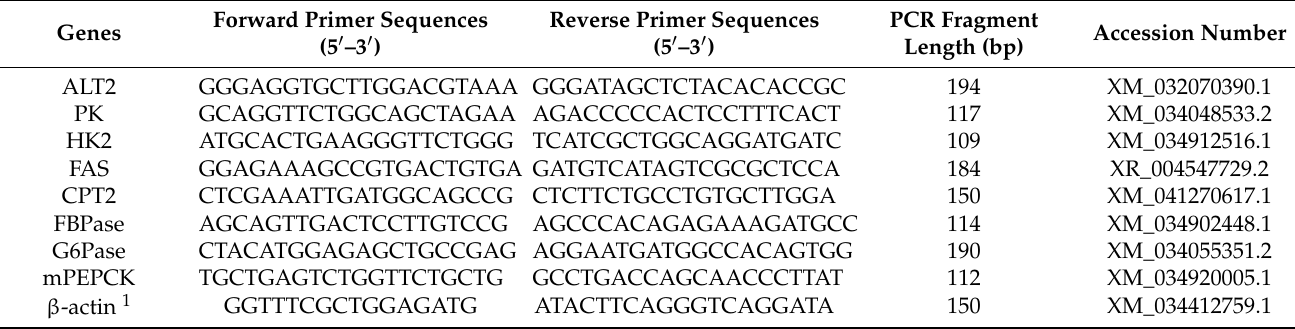
Table 2. Primers used for quantitative real-time